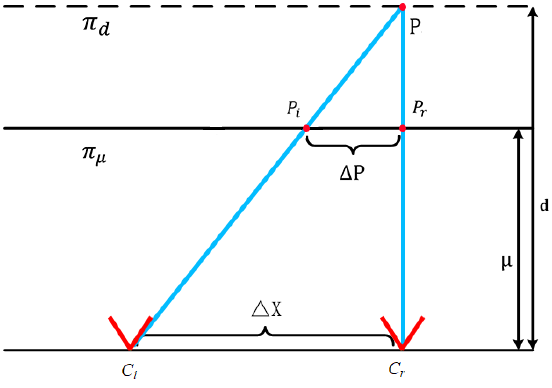
Figure 5. The planar parallax for camera